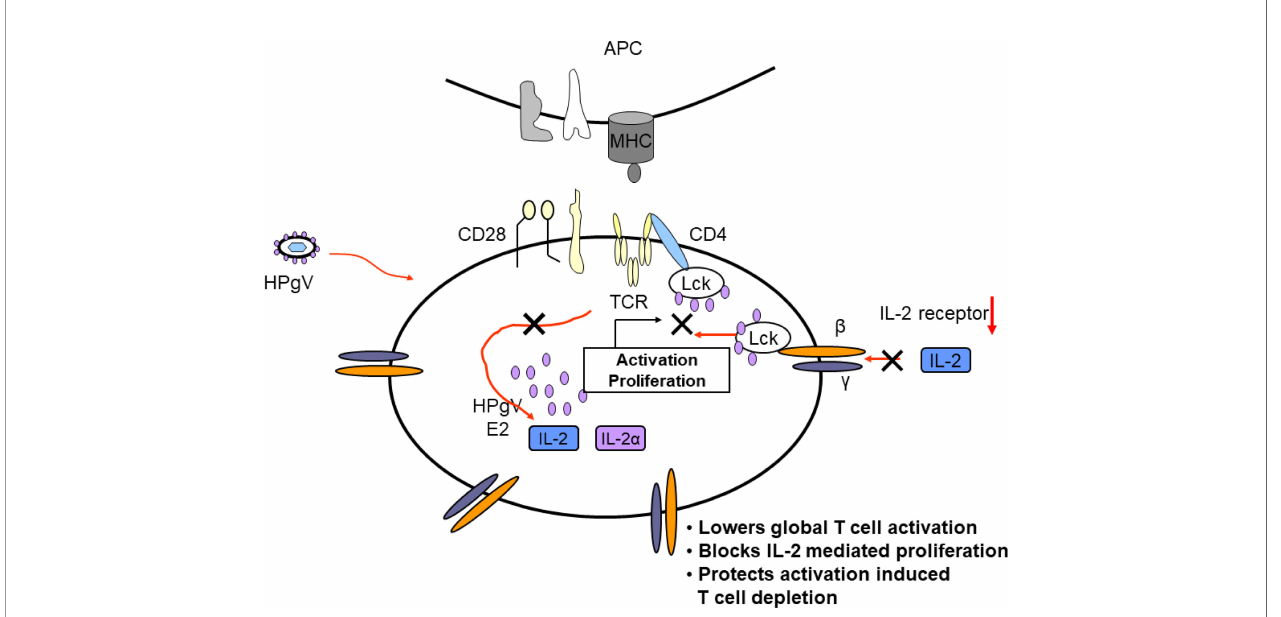
FIGURE 5 | Proposed model of mechanisms by which HPgV interferes with T cell activation, proliferation, and depletion. Virus particles containing HPgV E2 protein interact with T cell and other immune cells and genomic RNA is translated in the cytoplasm, producing additional E2 protein. The effects of HPgV particles and/or intracellular E2 proteins interfere with T cell receptor-mediated activation of Lck, reducing cellular IL-2 release. HPgV also interferes with IL-2 receptor function further reducing T cell activation and proliferation. These effects can be overcome with suf fi cient TCR